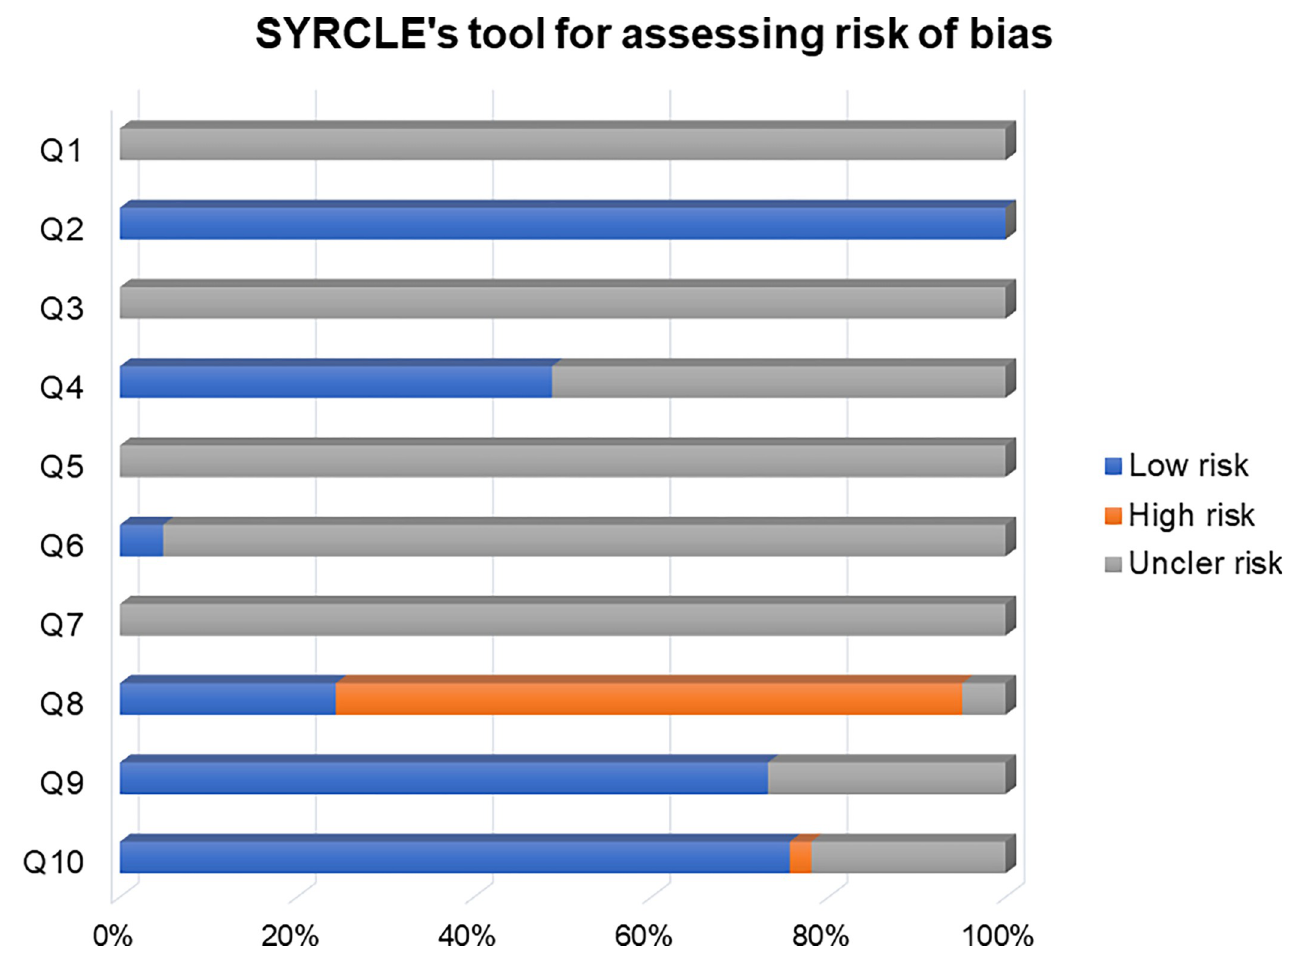
Fig 2. Risk of bias and methodological quality evaluation using the Systematic Review Center for Experimentation in Animal Laboratory (SYRCLE) tool to answer the question: What are the mechanisms of action of anti-inflammatory agents in adipose tissue?.